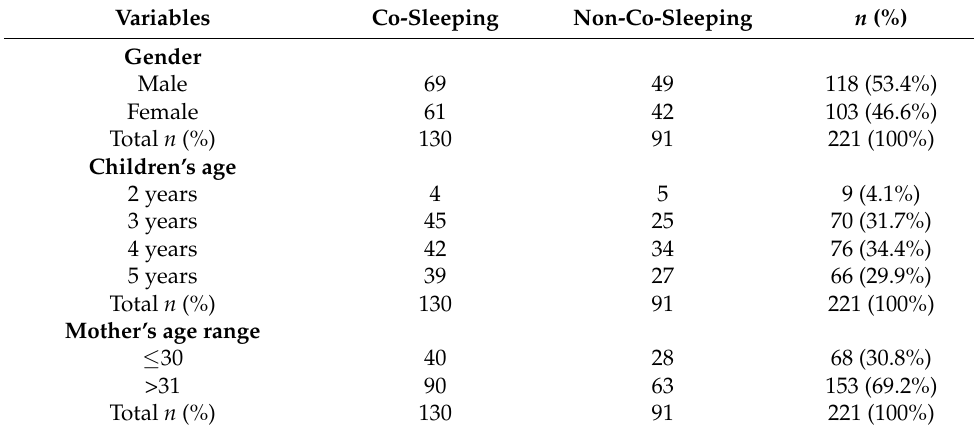
Table 1. Demographic characteristics of